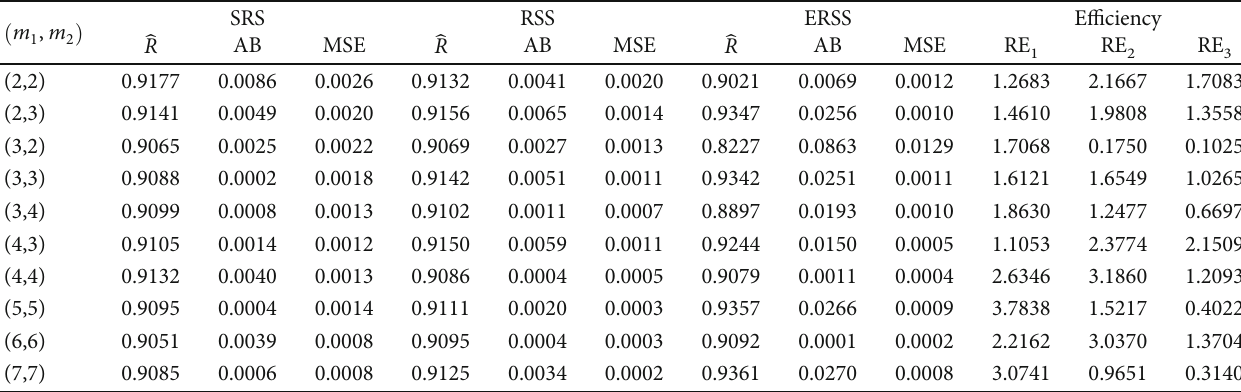
Table 3: Measures of ̂ R for di ff erent sampling schemes at R = 0 : 909